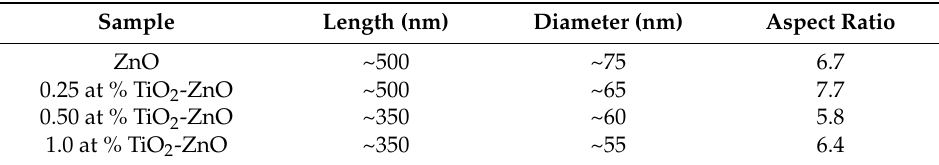
Table 3. The average value of length, diameter and aspect ratio for ZnO, 0.25 at % TiO 2 -ZnO, 0.50 at % TiO 2 -ZnO, and 1.0 at % TiO 2 -ZnO.